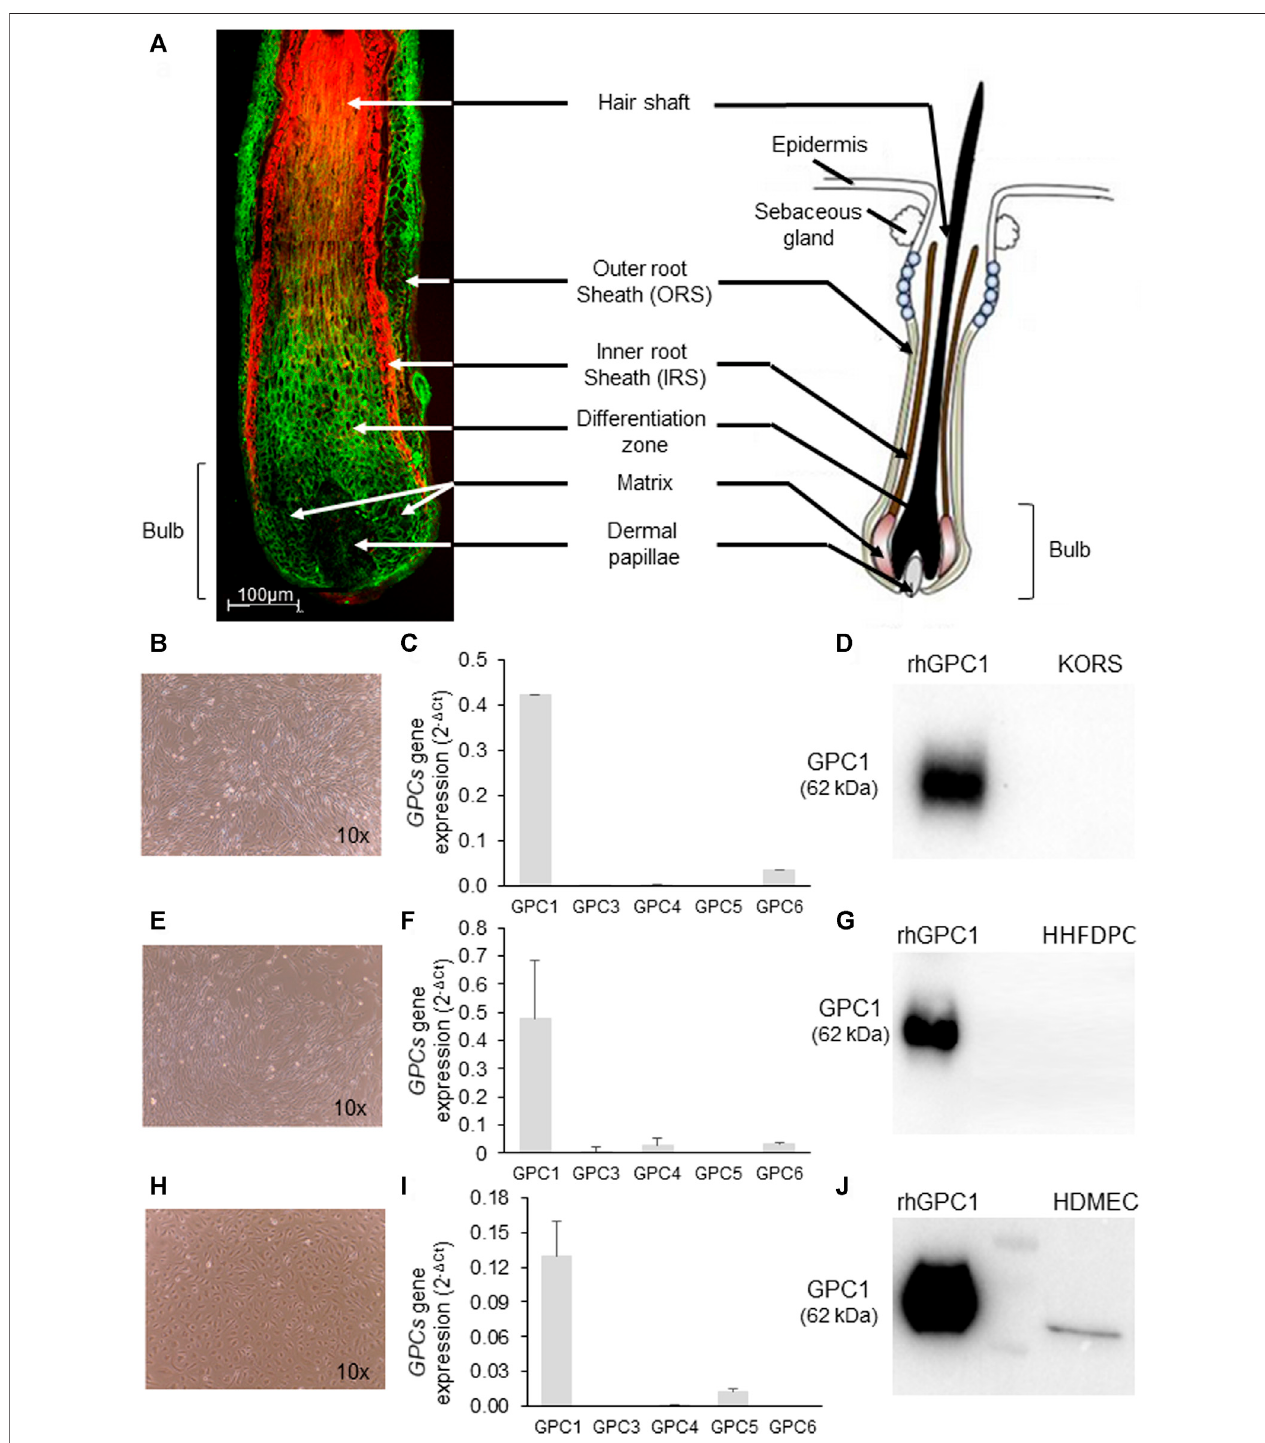
FIGURE1| Characterization ofGPC1 expression inhairfolliclesectionsand inKORS, HHFDPCand HDMECcultures. (A) RepresentativeGPC1 labeling(green)in hair follicle sections counterstained with Evans blue dye (red) of a 64-year-old donor. A schematic representation of a hair follicle is presented (adapted from Sada and Tumbar, 2013 (1)). (B – D) Cell morphology (10x), GPC gene expression analyzed by real time RT-PCR (mean ± SEM, n (cid:2) 10) and GPC1 protein expression analyzed by Western immunoblotting of KORS, respectively. (E – G) Cell morphology (10x), GPCs gene expression analyzed by real-time RT-PCR (mean ± SEM, n (cid:2) 10) and GPC1 protein expression analyzed by Western immunoblotting of HHFDPCs, respectively. (H – J) Cell morphology (10x), GPCs gene expression analyzed by real time RT-PCR (mean ± SEM, n (cid:2) 10) and GPC1 protein expression analyzed by Western immunoblotting of HDMECs, respectively.